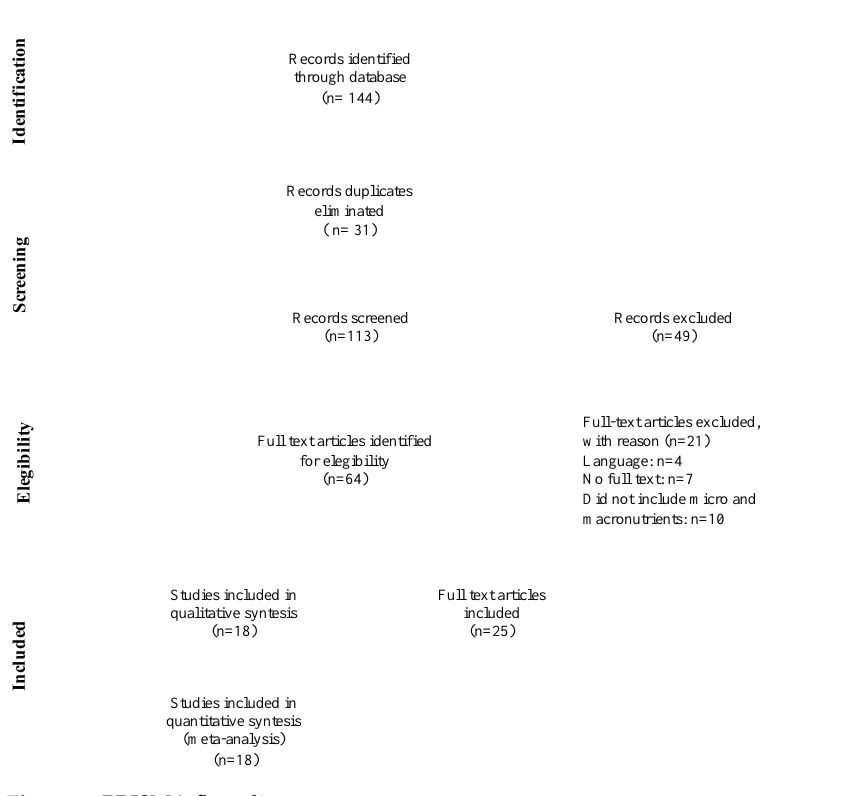
Figure 1. PRISMA flow diagram .